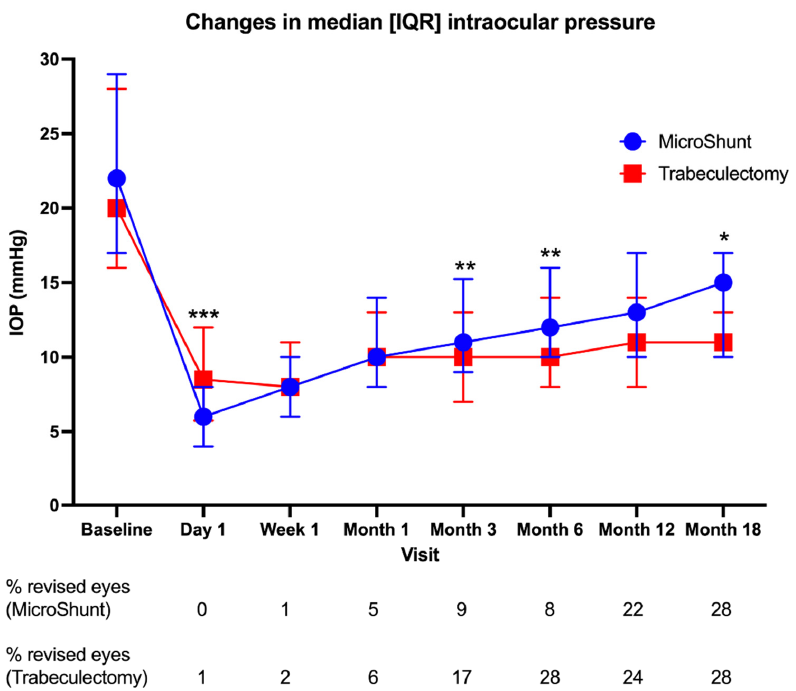
Figure 1. Changes in median IOP during follow-up after MicroShunt and trabeculectomy (* denotes p ≤ 0.050 between groups; ** denotes p ≤ 0.010 between groups, *** denotes p ≤ 0.001 between groups, assessed using Mann–Whitney U tests). Error bars represent interquartile ranges. The cumulative percentage of eyes undergoing bleb revision for each group as the proportion of the total number of available eyes for analysis is displayed under each time point.